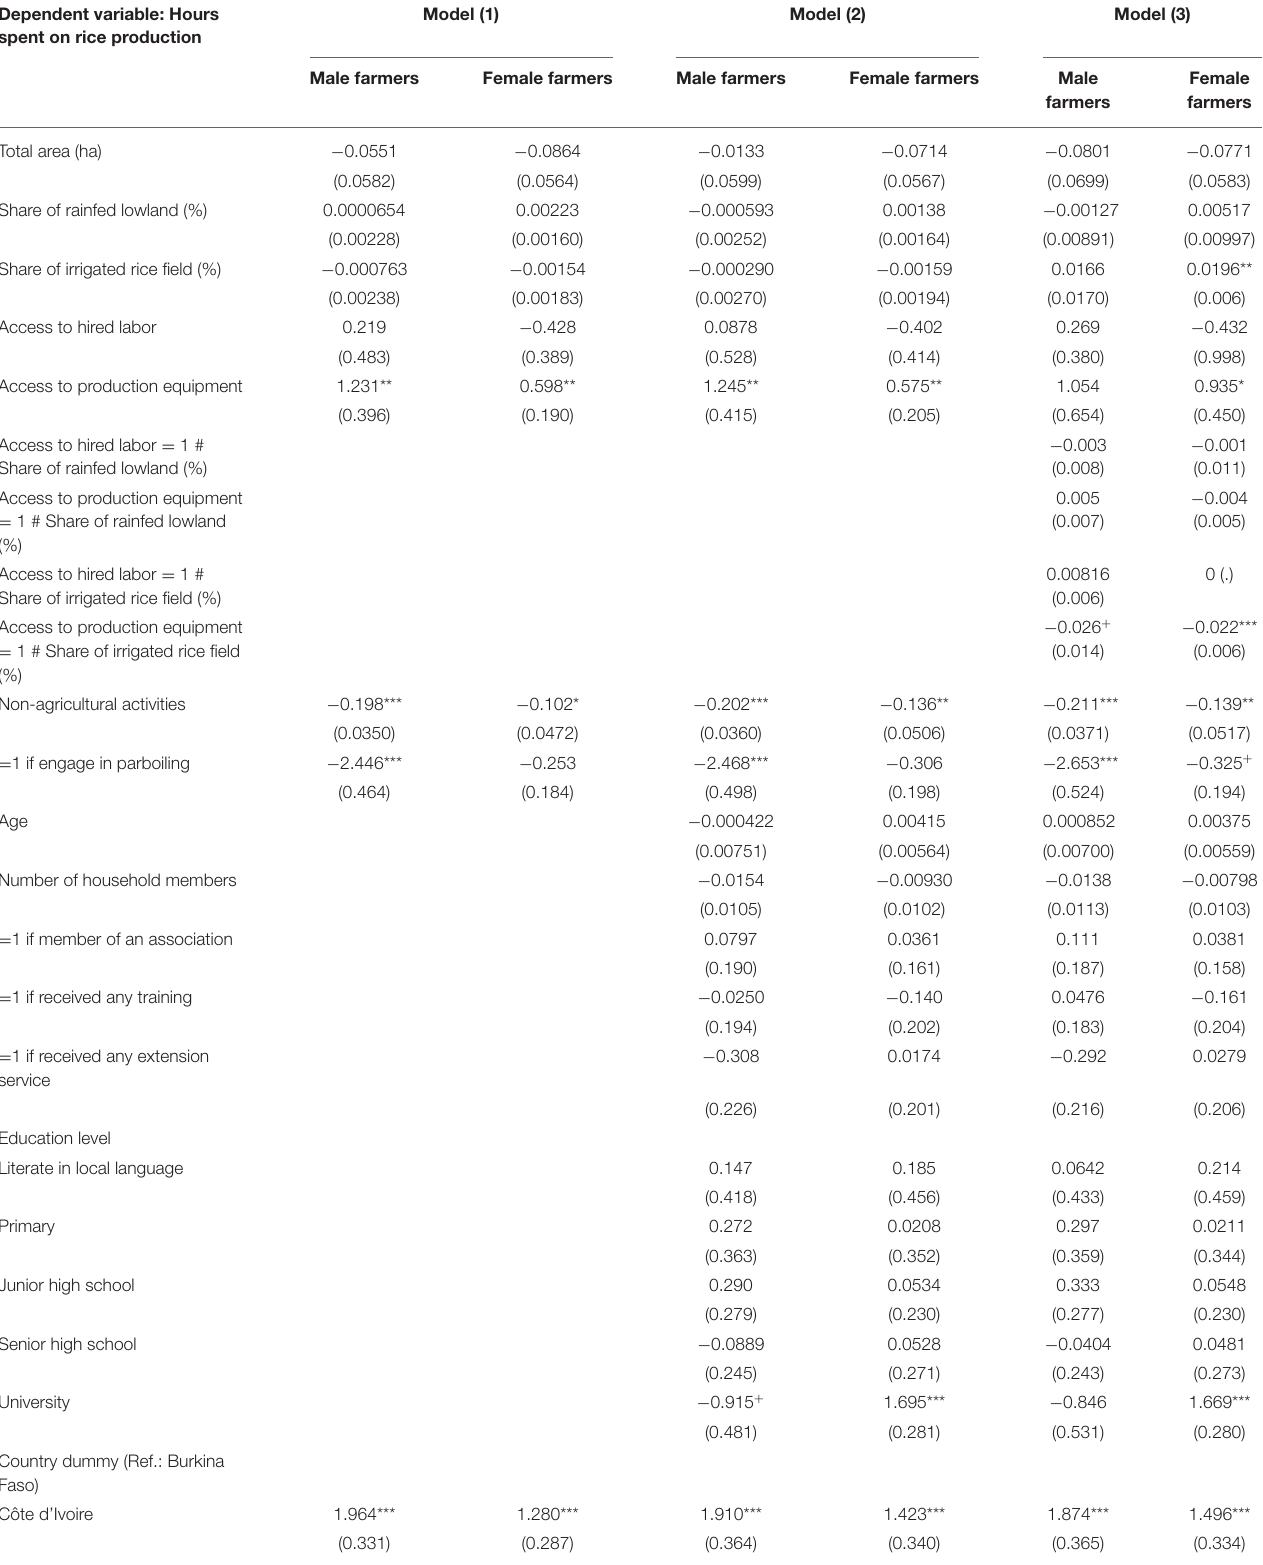
TABLE 5 | Regression results disaggregated by gender in Burkina Faso, Côte d’Ivoire, Madagascar, and Sierra Leone. Dependent variable: Hours spent on rice